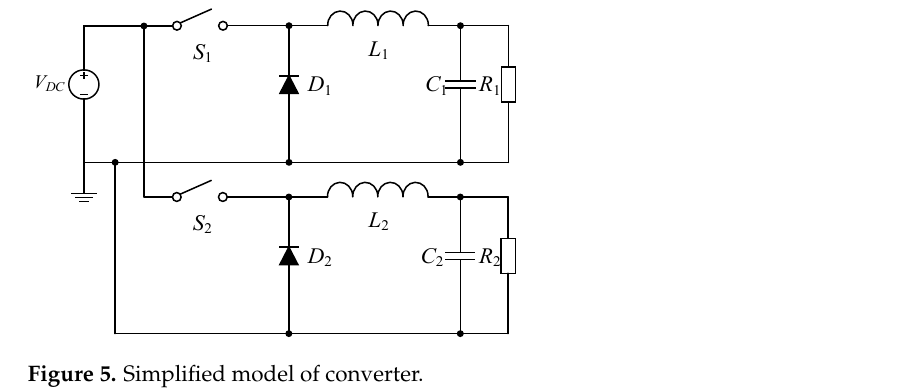
Figure 5. Simpli fi ed model of converter. Figure 5. Simplified model of